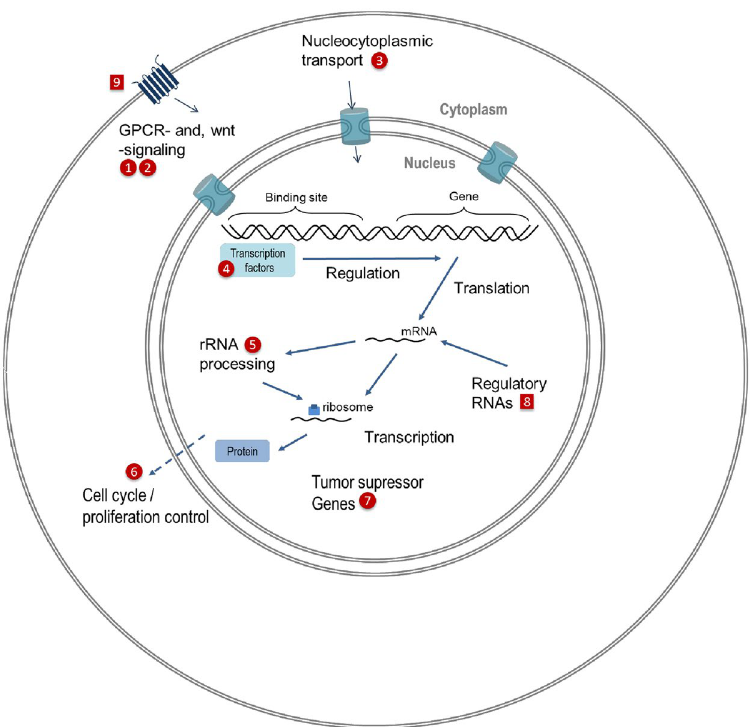
Figure 13. Hypothetical model of gravity-regulated cellular processes. Cellular processes and pathway components that were shown to be altered in microgravity and hypergravity during parabolic flight (numbers in squares) and sounding rocket flight (numbers in circles). The numbers represent the differentially expressed transcripts at their respective localization within the cell labeled with their participation in cellular processes. 1: MOB1B, MOB Kinase Activator 1B; 2: LOC644172, Mitogen-Activated Protein Kinase 8 Interacting Protein 1 Pseudogene; 3: KPNB1, Karyopherin Subunit Beta 1; 4: GTF3C6, General Transcription Factor IIIC Subunit 6; KLF12, Kruppel Like Factor 12; 5: MPHOSPH6, M-Phase Phosphoprotein 6; 6: CKS2, CDC28 Protein Kinase Regulatory Subunit 2; 7: ANP32C, Acidic Nuclear Phosphoprotein 32 Family Member C; ANP32D, Acidic Nuclear Phosphoprotein 32 Family Member D; 8: RNU5D-1, RNA U5D Small Nuclear 1; SNORD63, Small Nucleolar RNA C/D Box 63; AC083843.1; LOC732360; 9: OR12D3, Olfactory Receptor Family 12 Subfamily D Member 3.